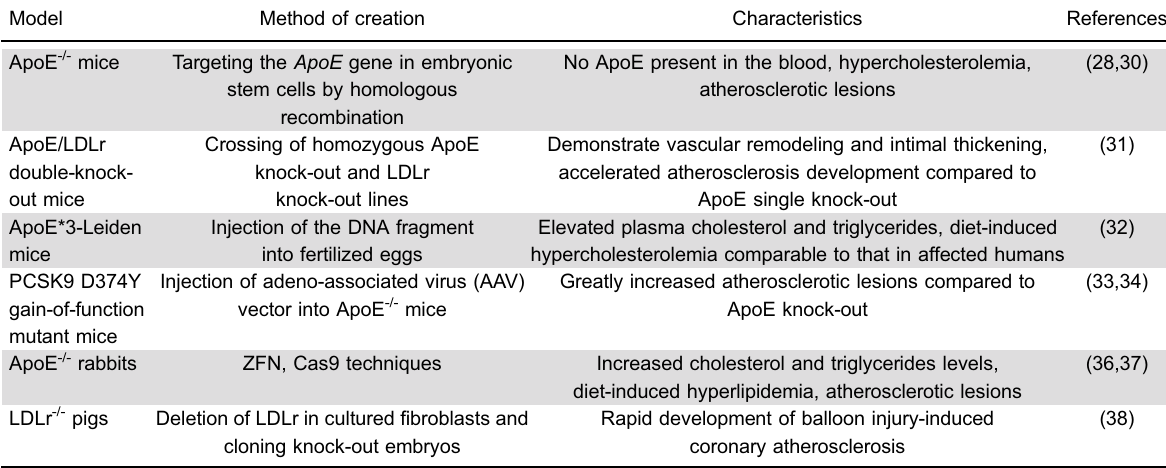
Table 2. Genetically engineered animal models of